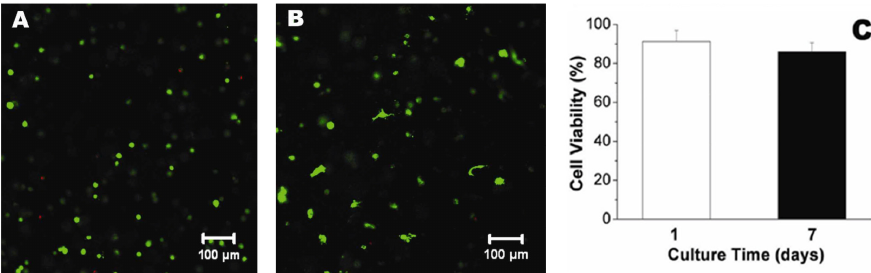
Figure 14. Live/Dead assay for encapsulated VICs within Alg/Gel hydrogel discs, ( A ) after 1 day and ( B ) after 7 days. ( C ) Cell viability measured based on Live/Dead images. Adapted with permission from ref. [133]. Copyright 2012, Wiley Periodicals.